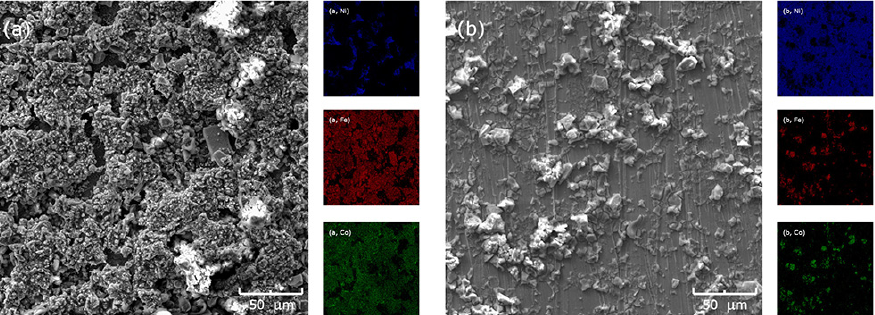
Figure 4. Surface morphology of ( a ) CFO PEG and ( b ) CFO Ni electrodes after 28 h of oxygen evolution at the current density j = 50 mAcm − 2 .